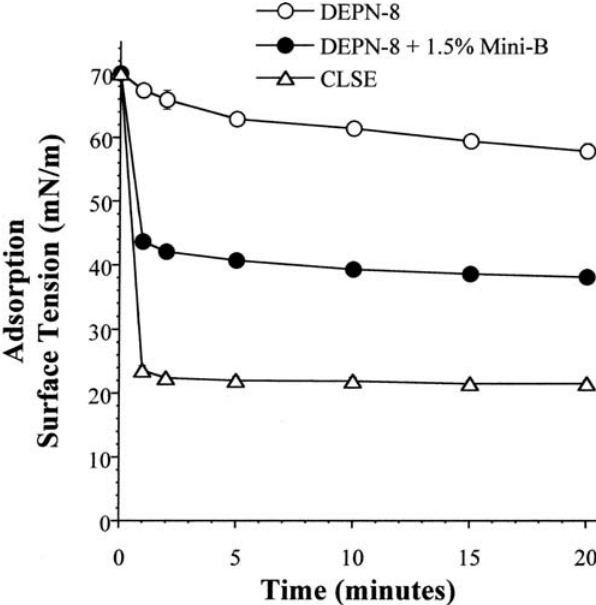
Figure 2. Adsorption of DEPN-8 with and without 1.5% (by wt) Mini-B compared to calf lung surfactant extract (CLSE). Adsorption surface tensions are plotted following the addition of a bolus of DEPN-8, DEPN- 8 + 1.5% Mini-B, or CLSE to a stirred subphase (10 mM HEPES with 0.15M NaCl and 1.5 mM CaCl 2 at pH 7.0) in a Teflon H dish at time zero. Final subphase surfactant concentration was uniform at 0.0625 mg lipid/ml. Data are Mean 6 SEM for n=3–5. See text for details.